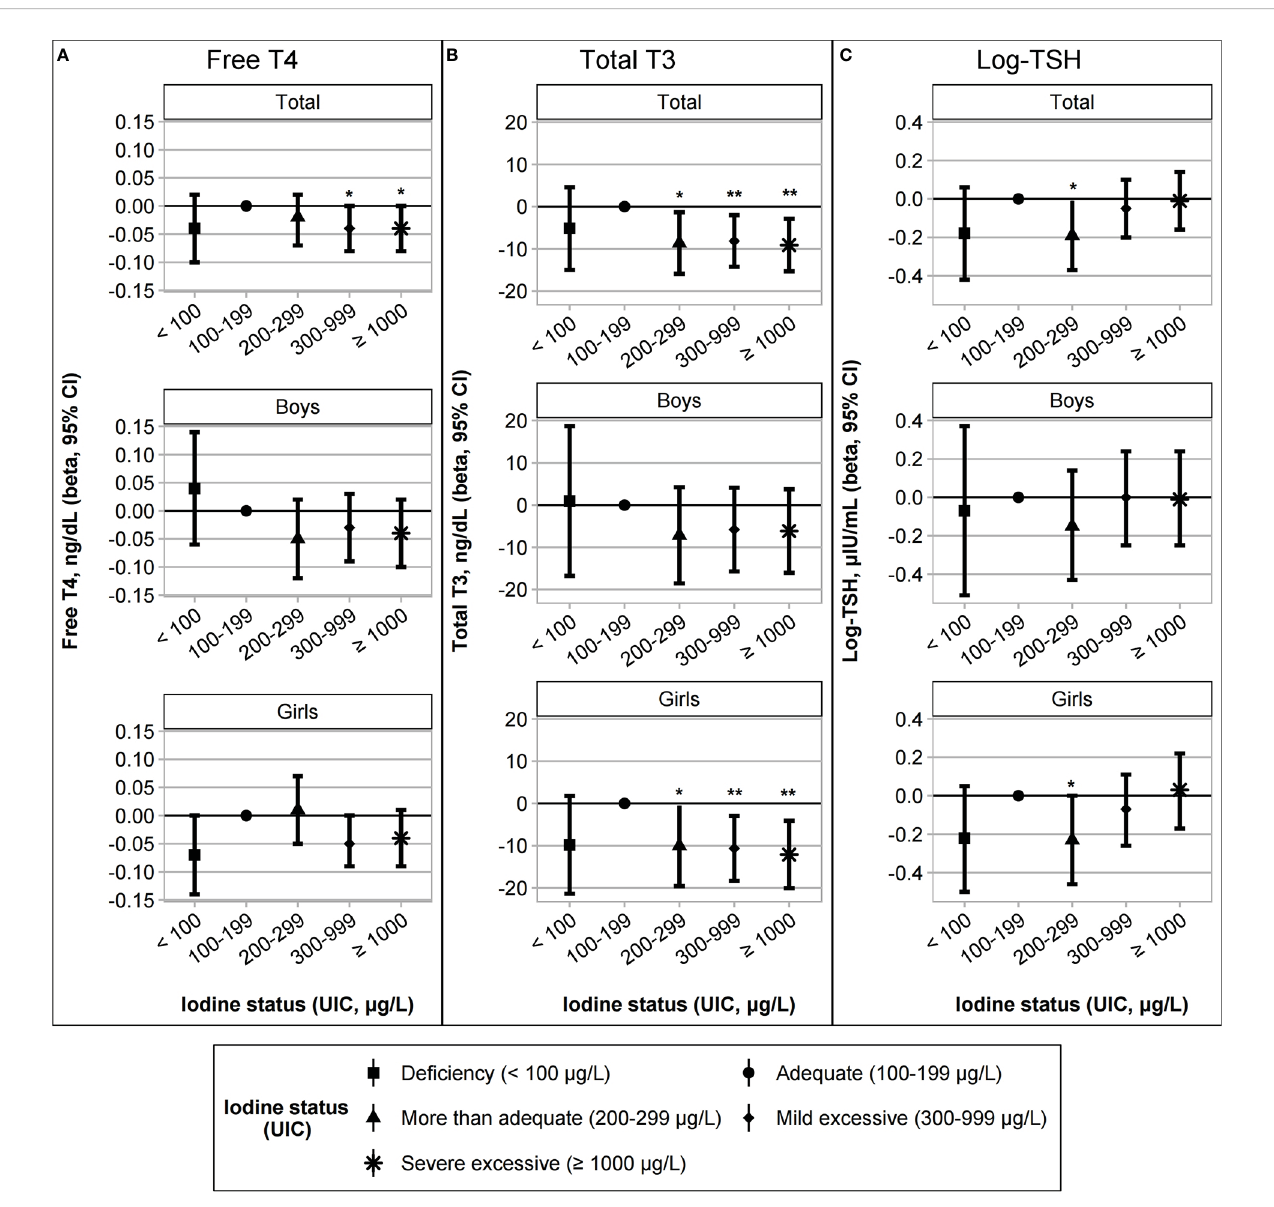
FIGURE 1 Association between iodine status and thyroid function (A) free T4, (B) total T3, and (C) log-transformed TSH levels. The iodine status groups were categorized as de fi cient (UIC < 100 m g/L, n = 19), adequate (UIC 100 – 199 m g/L, n = 42), more than adequate (UIC 200 – 299 m g/L, n = 54), mild excessive (UIC 300 – 999 m g/L, n = 170), or severe excessive (UIC ≥ 1000 m g/L, n = 154). Regression models for the total group were adjusted for age, sex, gestational age, birth weight, body mass index z-scores, and a parental history of thyroid disease. The sex-strati fi ed models were adjusted for age, gestational age, birth weight, body mass index z-scores, and parental history of thyroid disease. *p < 0.05; ** p <